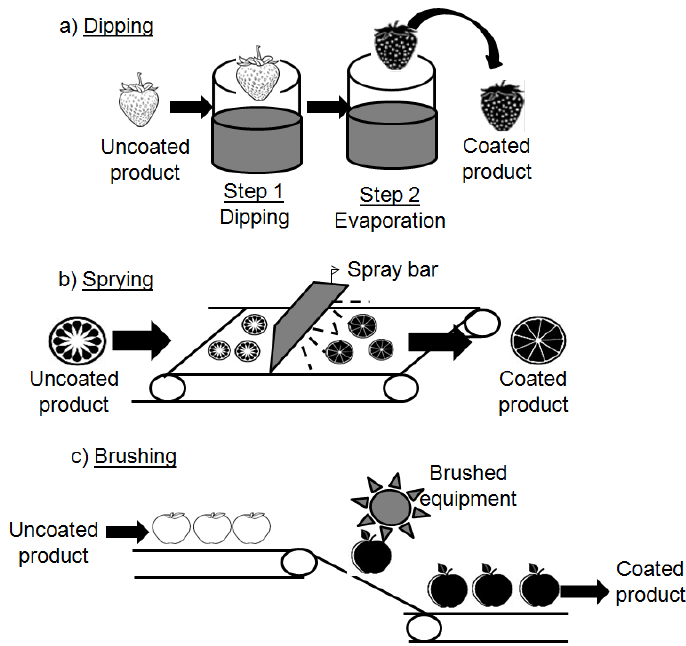
Figure 2. Main coating methods used in food industry. (Adapted from ref.